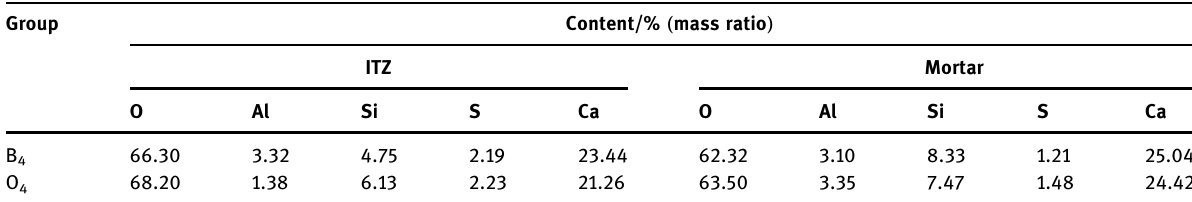
Table 9: Element composition of specimens by EDS analysis Group